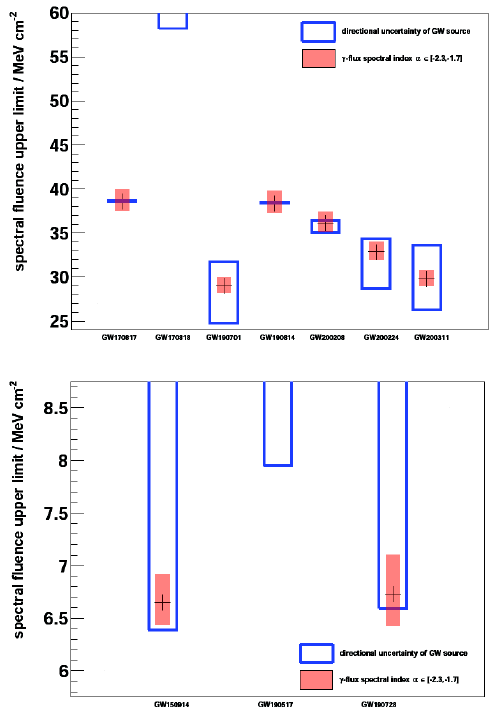
Figure 4. Upper limits (at 90% CL) on the spectral fluence of UHE photons from the selected GW sources for the searches in the long (top) and in the short-time window (bottom). The limits for the most likely direction and a spectral index of ↵ = -2 are marked by the cross. The blue (empty boxes) error bars corre- spond to the variation of the upper limits due to the directional uncertainty of the source. Red (shaded boxes) error bars show the impact of a variation of the spectral index. Further details in [9].